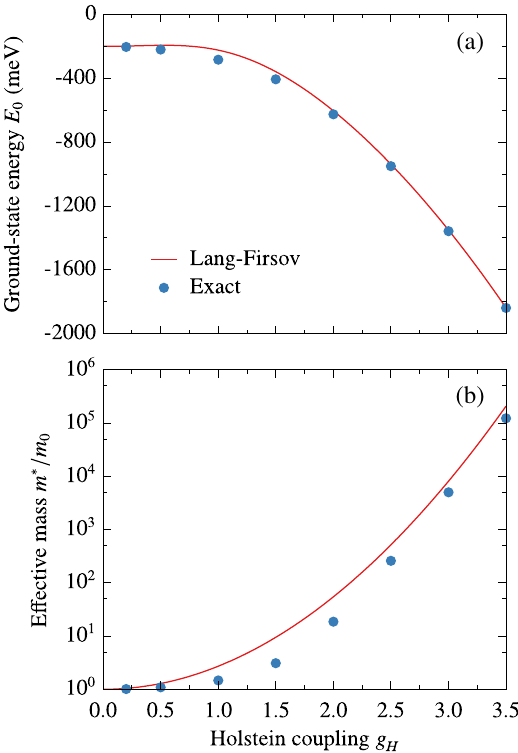
FIG. 6. (a) Ground-state energy E 0 and (b) effective mass enhancement m (cid:3) =m 0 of the Holstein polaron at zero temperature calculated via approximate Lang-Firsov and exact EDHVS. Calcu- lated for the weakly antiadiabatic case where τ ¼ 100 meV and ω 150 meV. H ¼